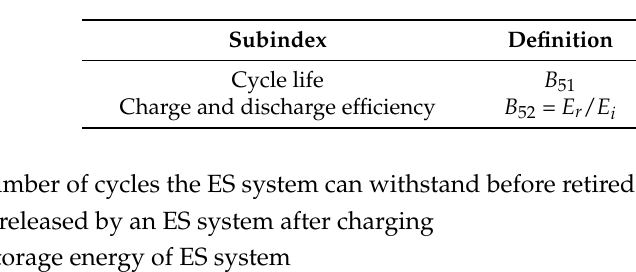
Table 6. Definition of discharge